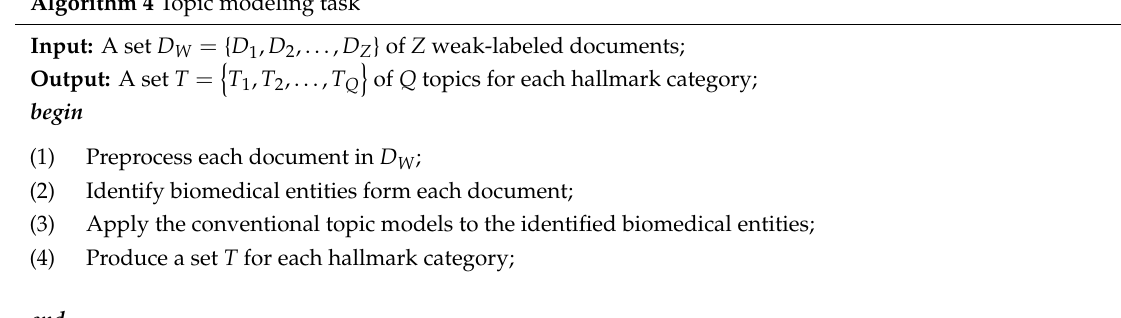
Algorithm 4 Topic modeling